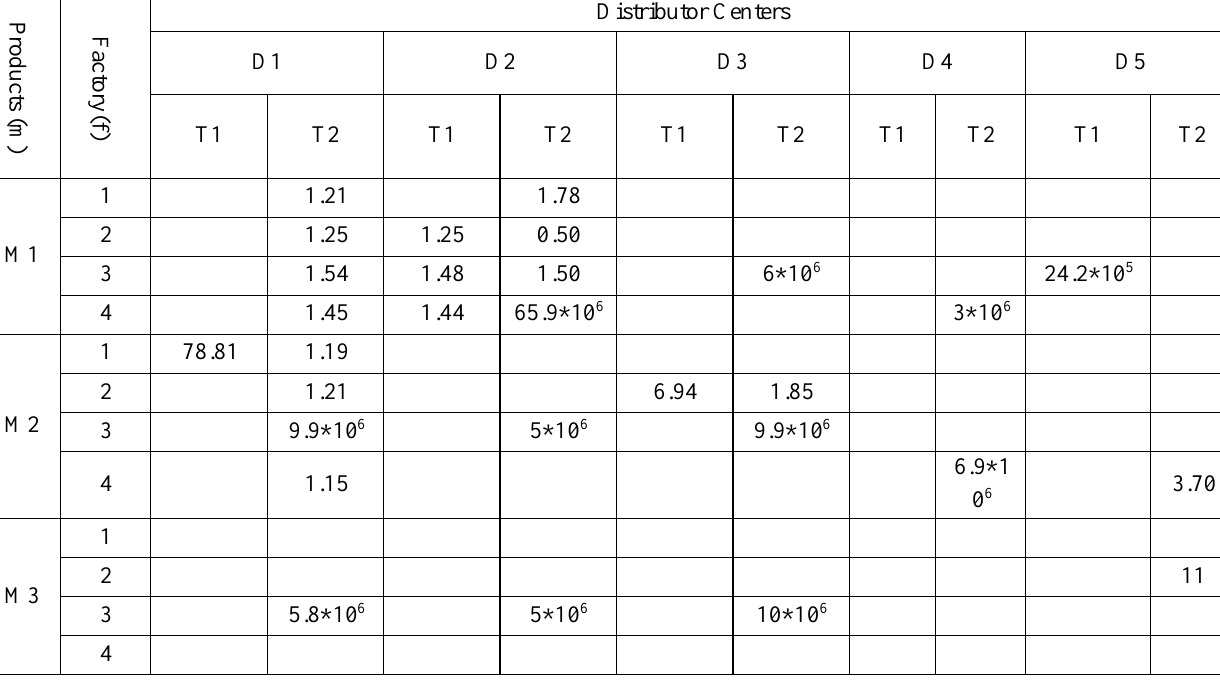
Table 10- amounts of end product which factory sends to each of distribution centers